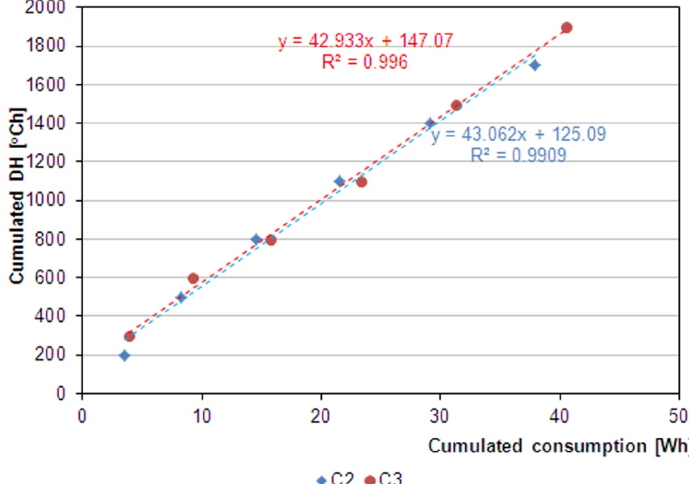
Figure 4. Calibration of energy consumption.